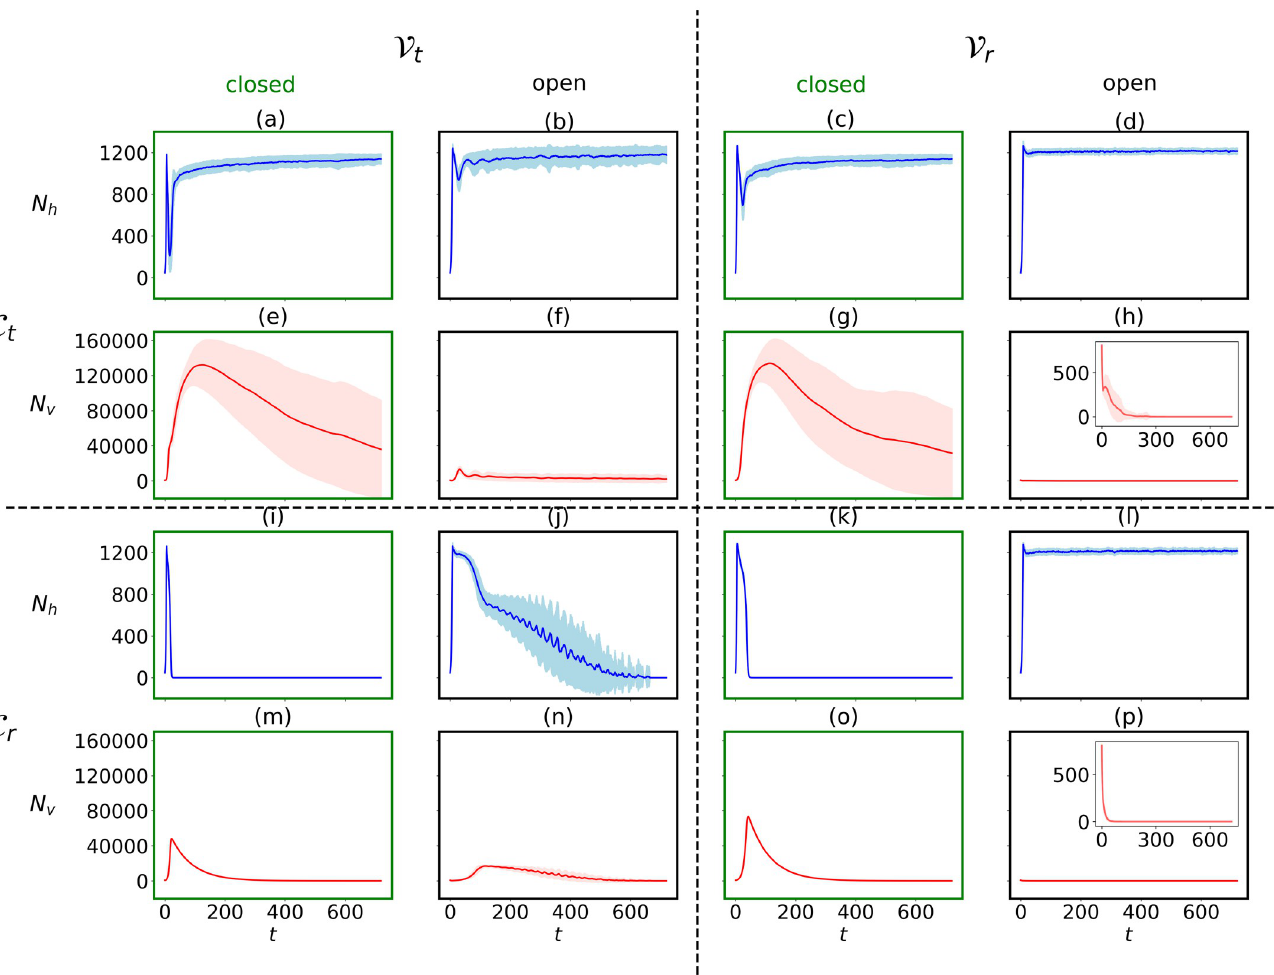
Fig 6. Model’s sensitivity to trade-off-based vs random infection processes. Host (a-d, i-l) and virus population dynamics (e-h, m-p) shown for closed systems and open systems with washout rate 0.2 h − 1 for genotypic compatibility and genotypic virulence ( C ( C , V , upper right), random compatibility and genotyipc virulence ( C t r Ensemble averages of 100 simulations (lines) with standard deviation (shaded areas) lasting for T = 720 h are shown. Sub-panels show virus dynamics on adjusted y-axis